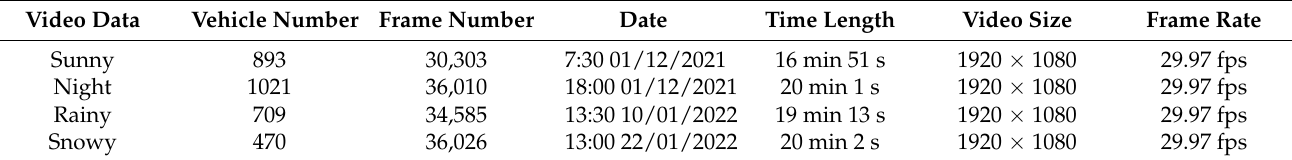
Table 5. Details of four UAV videos from the MWUAV dataset that were used in the experiment.